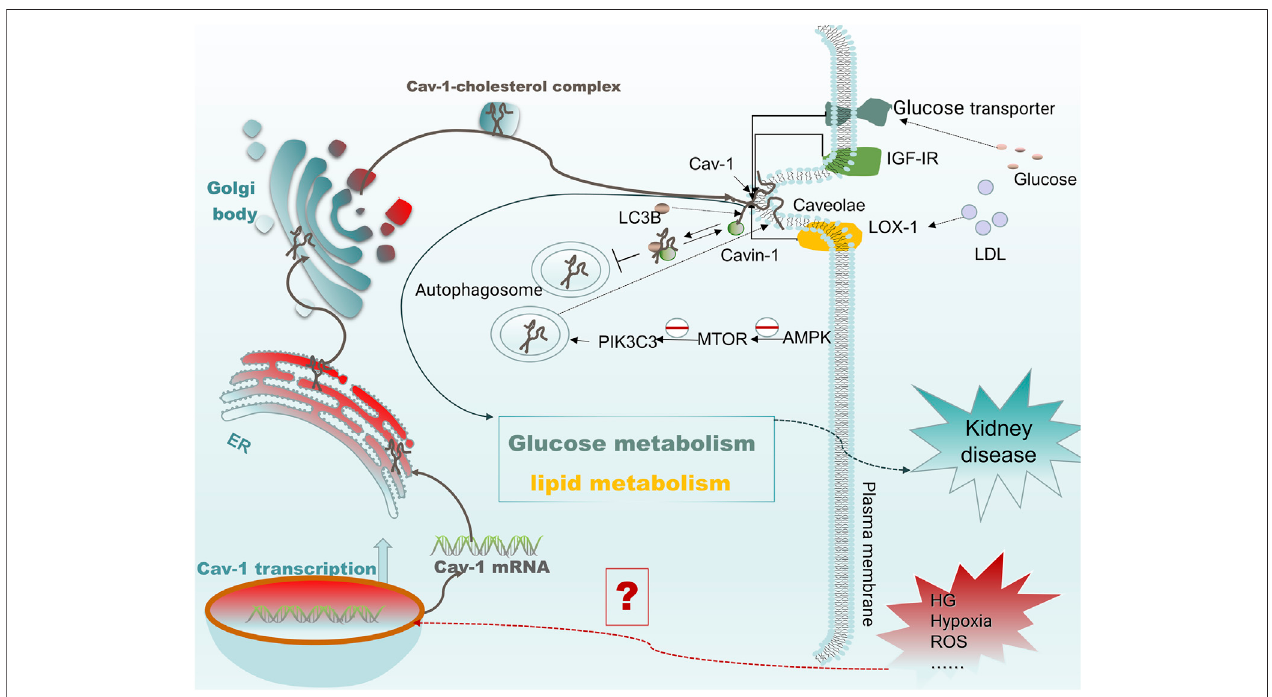
FIGURE 3 | Cav-1 mediates protein membrane targeting and regulates cellular metabolism. When cells are subjected to harmful external stimuli (such as high glucoseandoxidativestress),thetranscriptionlevelsof CAV1 increase,whichpromotestheformationofcaveolaeonthecellmembrane.TheexpressedCav-1canthen recruit receptors such as IGF-IR, glucose transporter, and LOX-1 to caveolae and bind there to Cav-1 and subsequently regulate glucose or lipid metabolism by mediating speci fi c receptor signals. In addition, under high glucose conditions, blocking autophagy induced by the AMPK-MTOR-PIK3C3 pathway reduces the degradation of Cav-1 by autophagy, resulting in increased expression of cavin and Cav-1. The high expression of Cav-1 recruits LC3B and binds together to inhibit the formation of autophagosomes, further inhibiting autophagic degradation of Cav-1 and leading to an increase in the formation of caveolae, which eventually mediates increased endocytosis of low-density